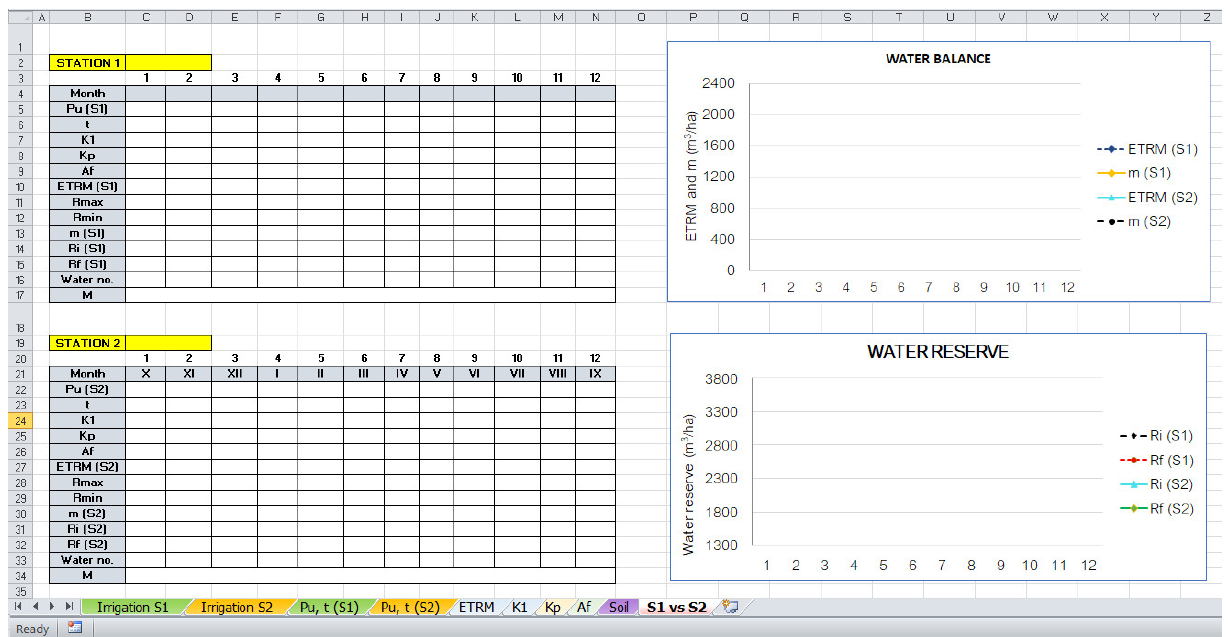
Figure 10. The “Soil” worksheet.